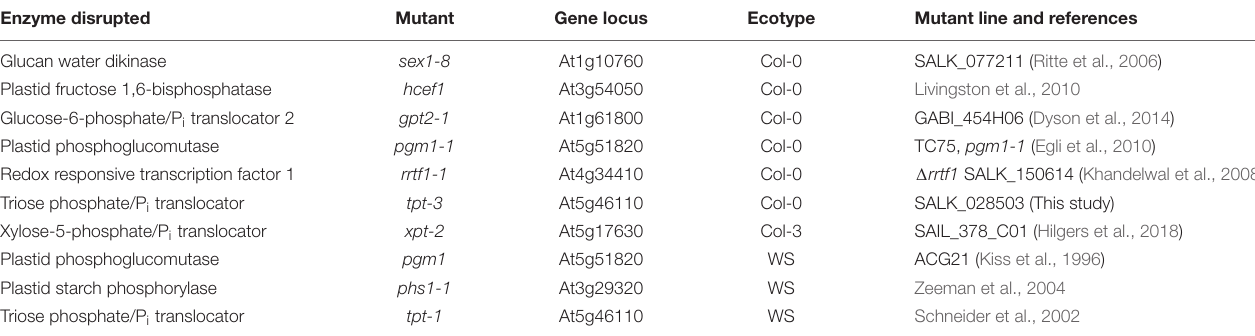
TABLE 1 | Arabidopsis mutants used in this